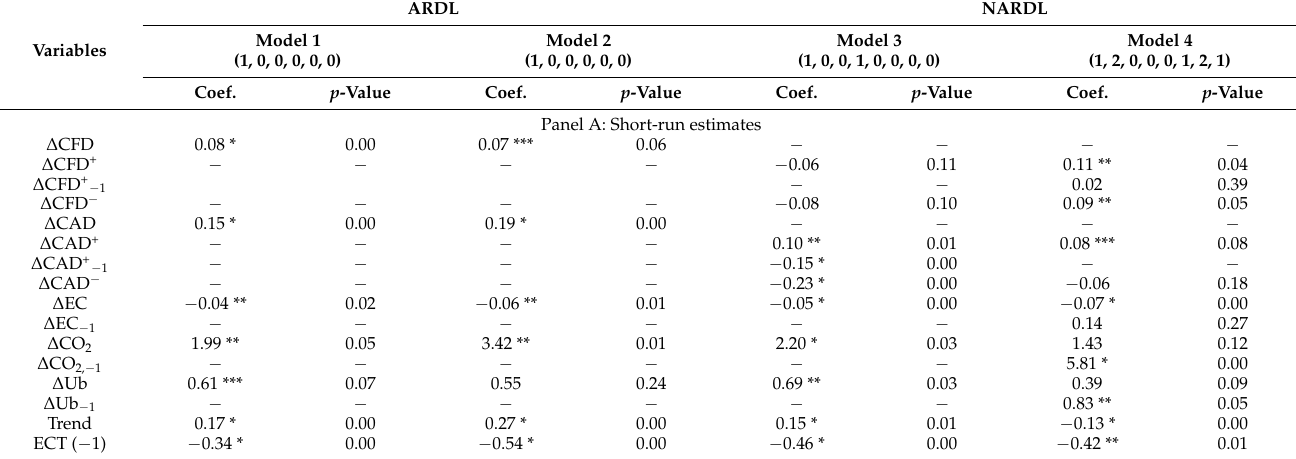
Table 5. Outcomes of ARDL and NARDL